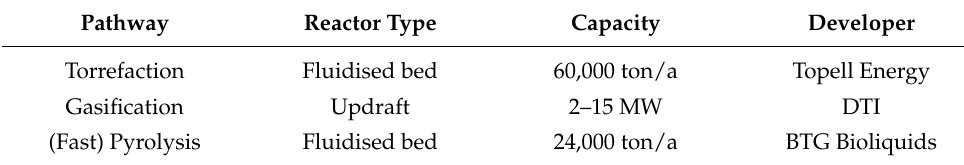
Table 4. Examples of commercially available thermochemical technologies. Pathway Reactor Type Capacity Developer Torrefaction Gasification (Fast) Pyrolysis Fluidised bed BTG